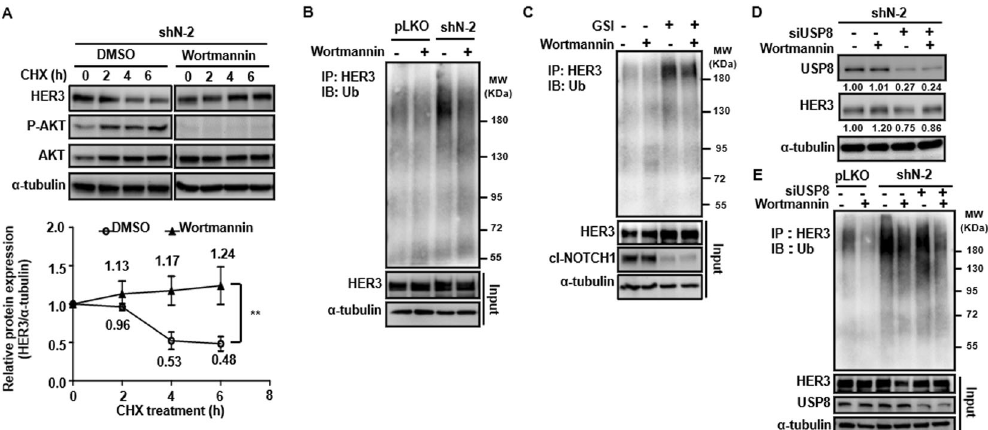
Fig. 3 NOTCH1 downregulation promotes degradation of HER3 protein via suppression of deubiquitinating enzyme USP8 through activated AKT signaling. A The protein level of HER3 steadily increased over 6 h following treatment with wortmannin (10 μ M) in HER3- recapitulated, NOTCH1-knockdown SCCHN FaDu cells. In contrast, the HER3 protein level was less than 50% of the original level in the DMSO- treated control group. Dot: average relative expression normalized to the original levels ± standard error ( n = 3). ** p < 0.01 by two-way ANOVA. B Immunoprecipitation experiments also showed wortmannin lowered HER3 polyubiquitination in both control FaDu cells (two lanes on the left) and NOTCH1-knockdown cells (two lanes on the right). Polyubiquitination of HER3 was more prominent in NOTCH1-knockdown cells than in control cells. C Similar results were found when the NOTCH1 function was compromised by GSI. D When USP8 was stimulated by wortmannin, the protein level of HER3 in NOTCH1-knockdown FaDu cells increased (two lanes on the left), while HER3 protein was reduced after the introduction of siRNA against USP8 (two lanes on the right). In addition, treatment with wortmannin partially rescued the expression of HER3. E Ubiquitination of HER3 was decreased in both control and NOTCH1-knockdown SCCHN cells after treatment with wortmannin, which resulted in enhancement of USP8. This suppression could be partially reversed by the siRNA knockdown of